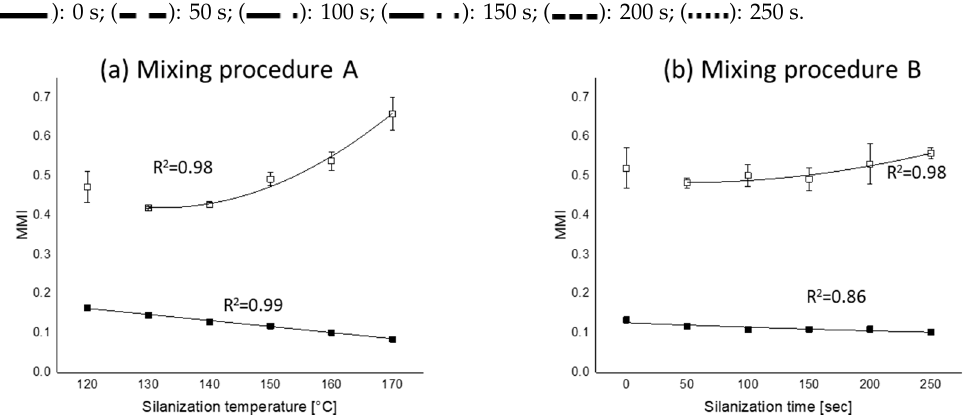
Figure 12. Marching modulus intensity (MMI) as a function of silanization temperature and time: ( a ) MMI vs. silanization temperatures and ( b ) MMI vs. silanization time; ( ): MMI 0.5°; ( ): MMI 3°; fitting lines for each MMI in ( a , b ) are based on linear or polynomial fit with maximum R 2 .